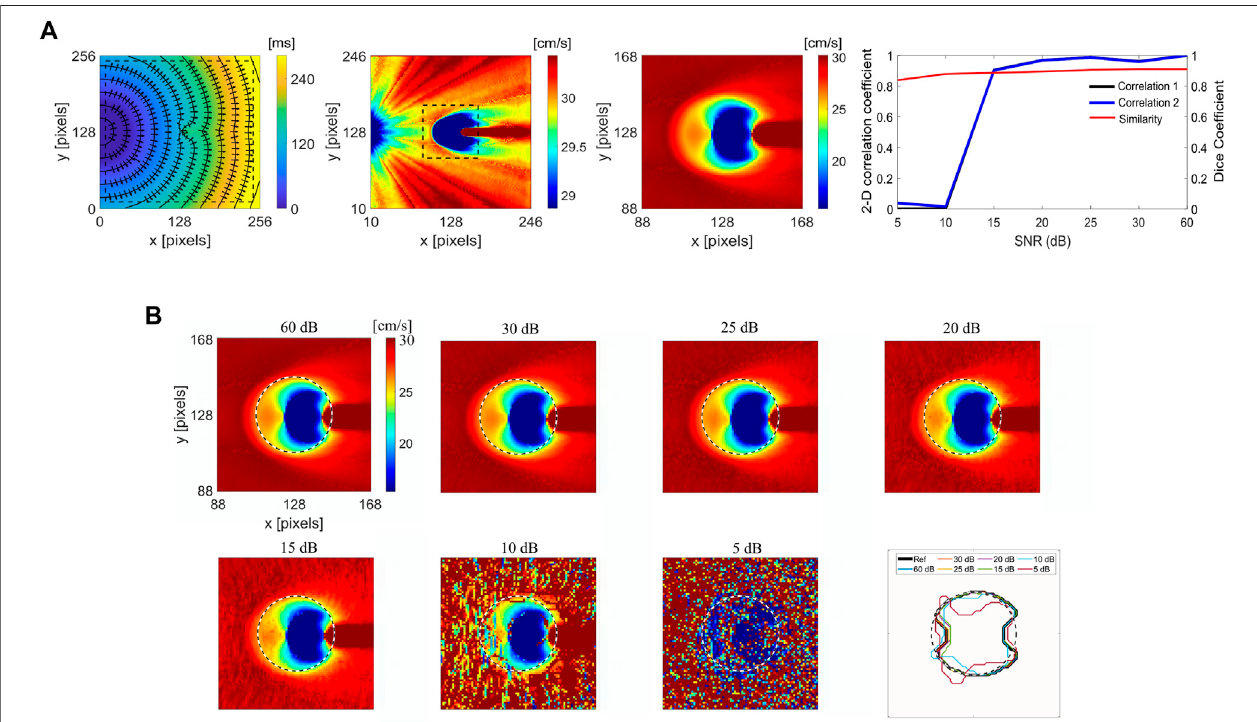
FIGURE 2 | Numerical simulations of the RFA and effects of added noise on CV for the spatial determination of the ablation area. (A) Left, the LAT map of a simulatedcurvedwavefrontpropagationwithisochronelinesspaced20 msapart,andsuperimposedCVvectormapshowingCVmagnitudeanddirection.Theablated area is modeled as a circular region, 20 pixels radius at the center. Middle, the corresponding CV maps from the LAT map for the whole domain and sub-domain (80 × 80 pixels) region around the ablated area outlined with an inscribed dashed rectangle. Right, 2D Pearson ’ s correlation coef fi cient for different SNR levels ranging from 5 to 60 dB, for the CV maps of different sizes on the left, 236 × 236 (Correlation 1) and 80 × 80 pixels (Correlation 2). The Dice similarity coef fi cient for the selected 80×80pixelsCVmaparoundtheablatedarea. (B) Zoomed-inCVsurrogatemapsfordifferentSNRsof60,30,25,20,15,10,and5 dB,withthedelineatedboundaryof the ablated area. The color bar range in all fi gures is set from the 5th to 95th